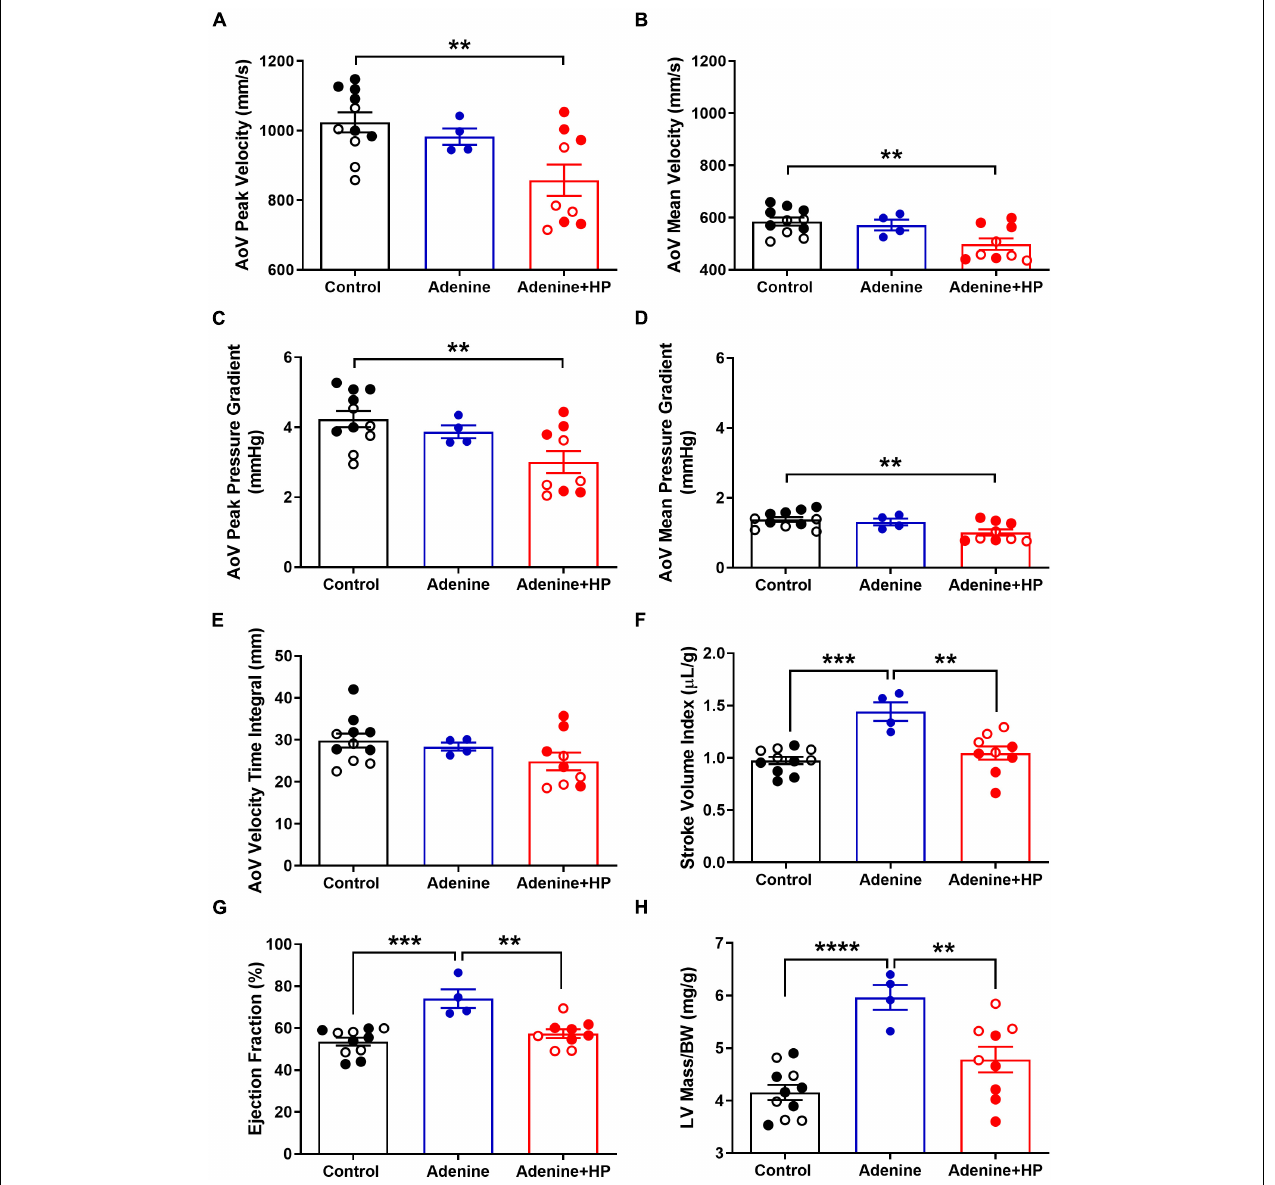
FIGURE 8 | Echocardiographic measures of aortic valve and cardiac function. Aortic valve (AoV) and cardiac function assessed by echocardiography. AoV (A) peak velocity, (B) mean velocity, (C) peak pressure gradient, (D) mean pressure gradient, and (E) velocity time integral in Control, Adenine, and Adenine + HP mice. (F) Stroke volume, (G) ejection fraction, and (H) corrected LV mass in Control, Adenine, and Adenine + HP mice. One-way ANOVA with Tukey’s multiple comparisons test: * P < 0.05, ** P < 0.01, *** P < 0.001, **** P < 0.0001. Male mice ( ) and female mice ( (cid:13) ). LV, left ventricle; BW, body (cid:32)